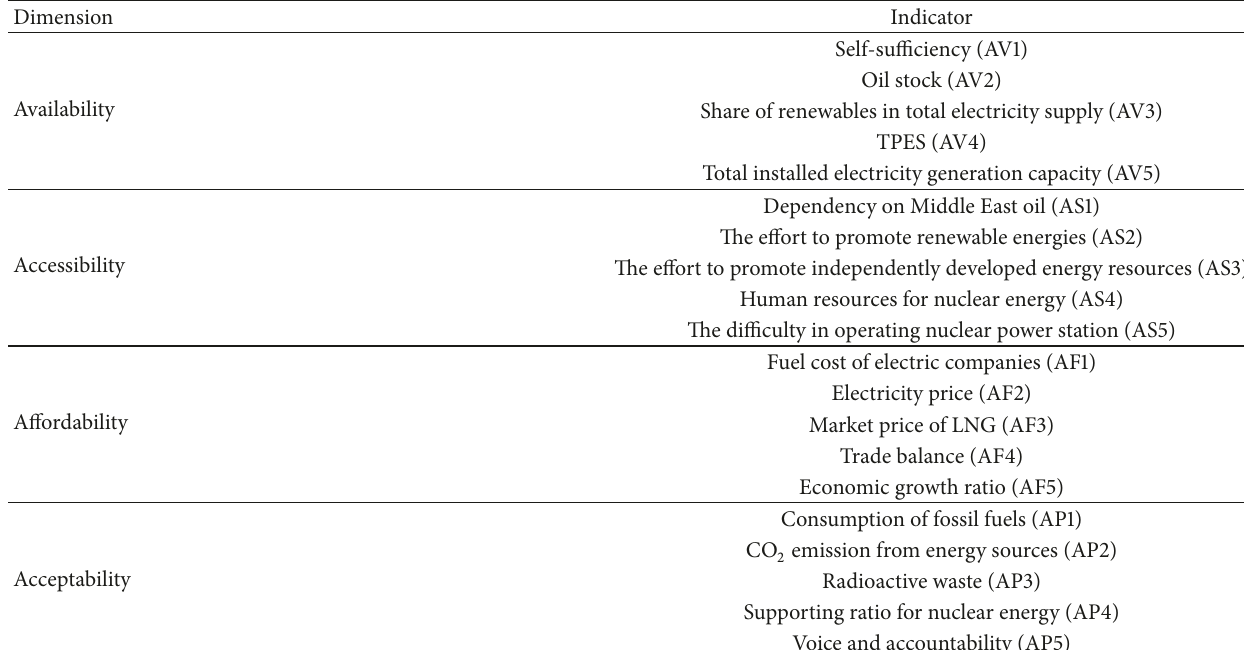
Table 1: Selected indicators of energy